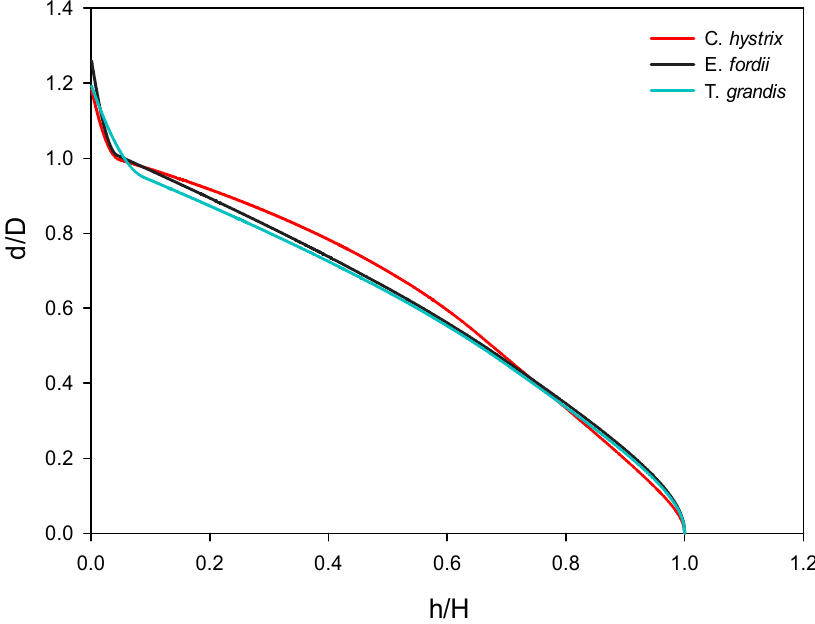
Figure 8. The predicted taper curves from Equation (1) using the combined method of constrained two-dimensional optimum seeking and least square regression (CTOS & LSR) for the three tree species C. hystrix (red line), E. fordii (black line), and T. grandi (blue line) at the population average level.